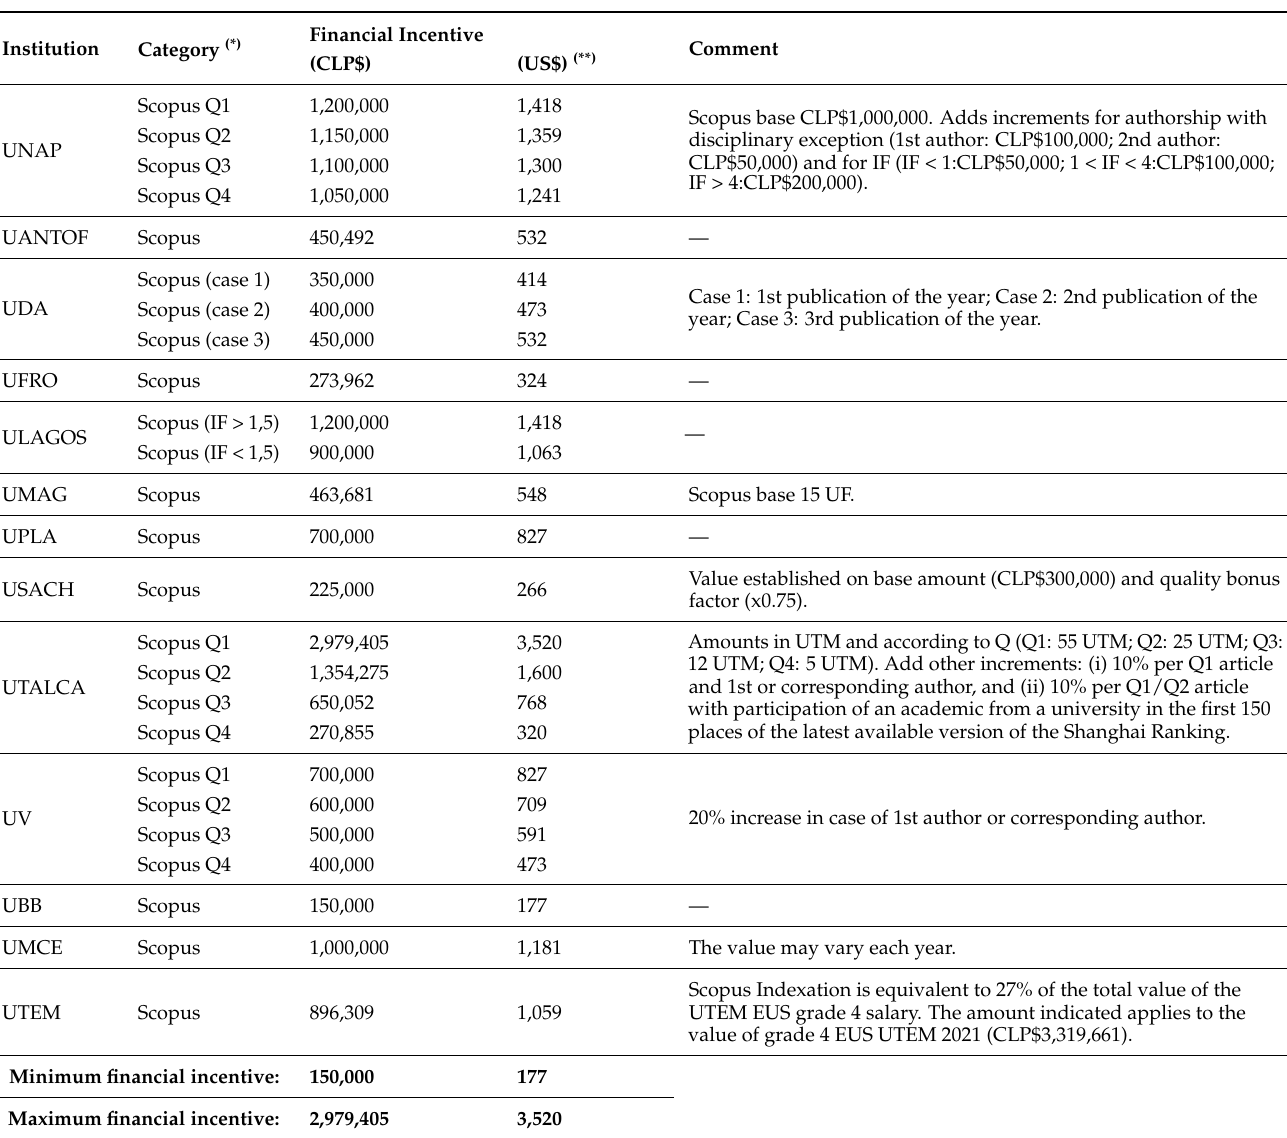
Table 5. Incentive amounts for publications indexed in the Scopus